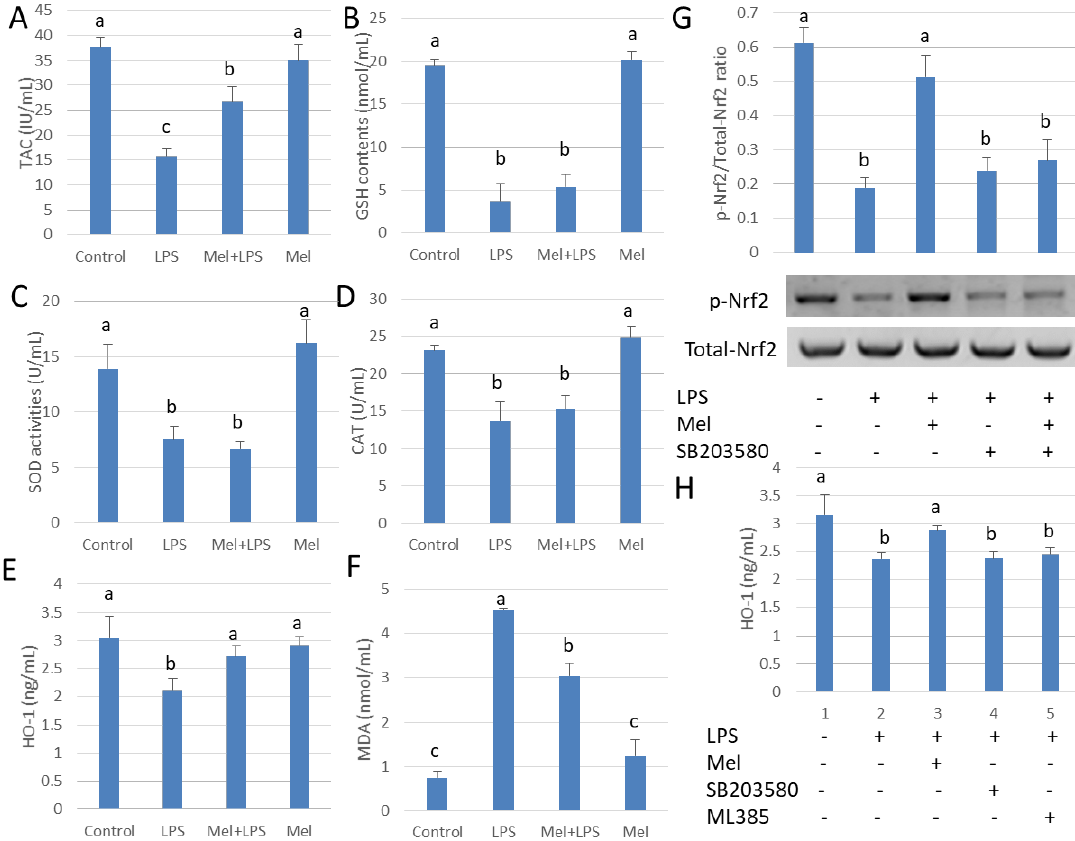
Figure 5. Melatonin up-regulated HO-1 expression attenuates LPS-induced oxidative damage in testicular macrophages. ( A ) TAC activation. ( B ) GSH activation. ( C ) SOD activation. ( D ) CAT activation. ( E ) ELISA detection for HO-1 protein expression. ( F ) MDA content. Experiments were carried out into control group, LPS infection group, Mel+LPS group and Mel group. ( G ) Western blotting using to detect p-Nrf2/Nrf2 expression. TM treated with LPS, Mel and/or SB203580. ( H ) ELISA used to detect HO-1 protein expression. TM treated with LPS, Mel, ML385 and/or SB203580. Data are shown as mean ± SEM. Different superscript letters (a–c) in each column representative statistically significant differences ( p < 0.05).